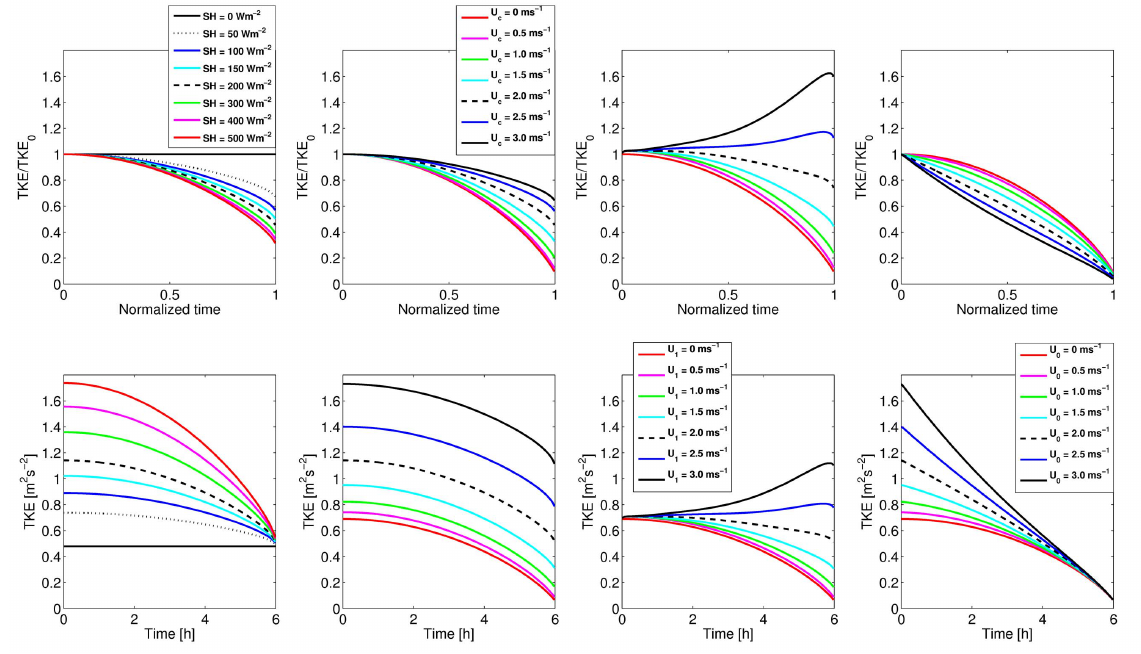
Figure 12. The lower row shows the evolution of modeled TKE at 2m for the afternoon period in four sets of numerical simulations. In the upper row, the same simulation results are shown after dividing the TKE by the midday TKE value for each simulation and normalizing time with the length of the afternoon (here 6h). From left to right the simulation results shown are from the SH, U c , U inc and U dec numerical experiments and the legends show the relevant variable value set for each simulation. The legends shown apply to both upper and lower